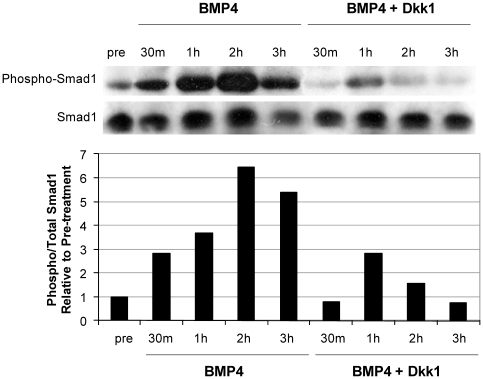
Wnt/β-catenin signaling regulates Smad1 activation.High-density undifferentiated human ES cells were treated with activin A for 24 hours followed by BMP4 or BMP4 plus Dkk1. Lane marked as “pre” indicates cells collected prior to cytokine treatment. Western blot shows probing for C-terminal phosphorylated Smad1 (p-Smad1) and total Smad1 at 30 m, 1 h, 2 h and 3 h following BMP4. Densitometry data are presented as phosphorylated Smad1 normalized to total Smad1 relative to pretreated cultures. Treatment with BMP4 increased phosphorylation of Smad1, which was reduced by inhibition of canonical Wnt signaling with Dkk1.